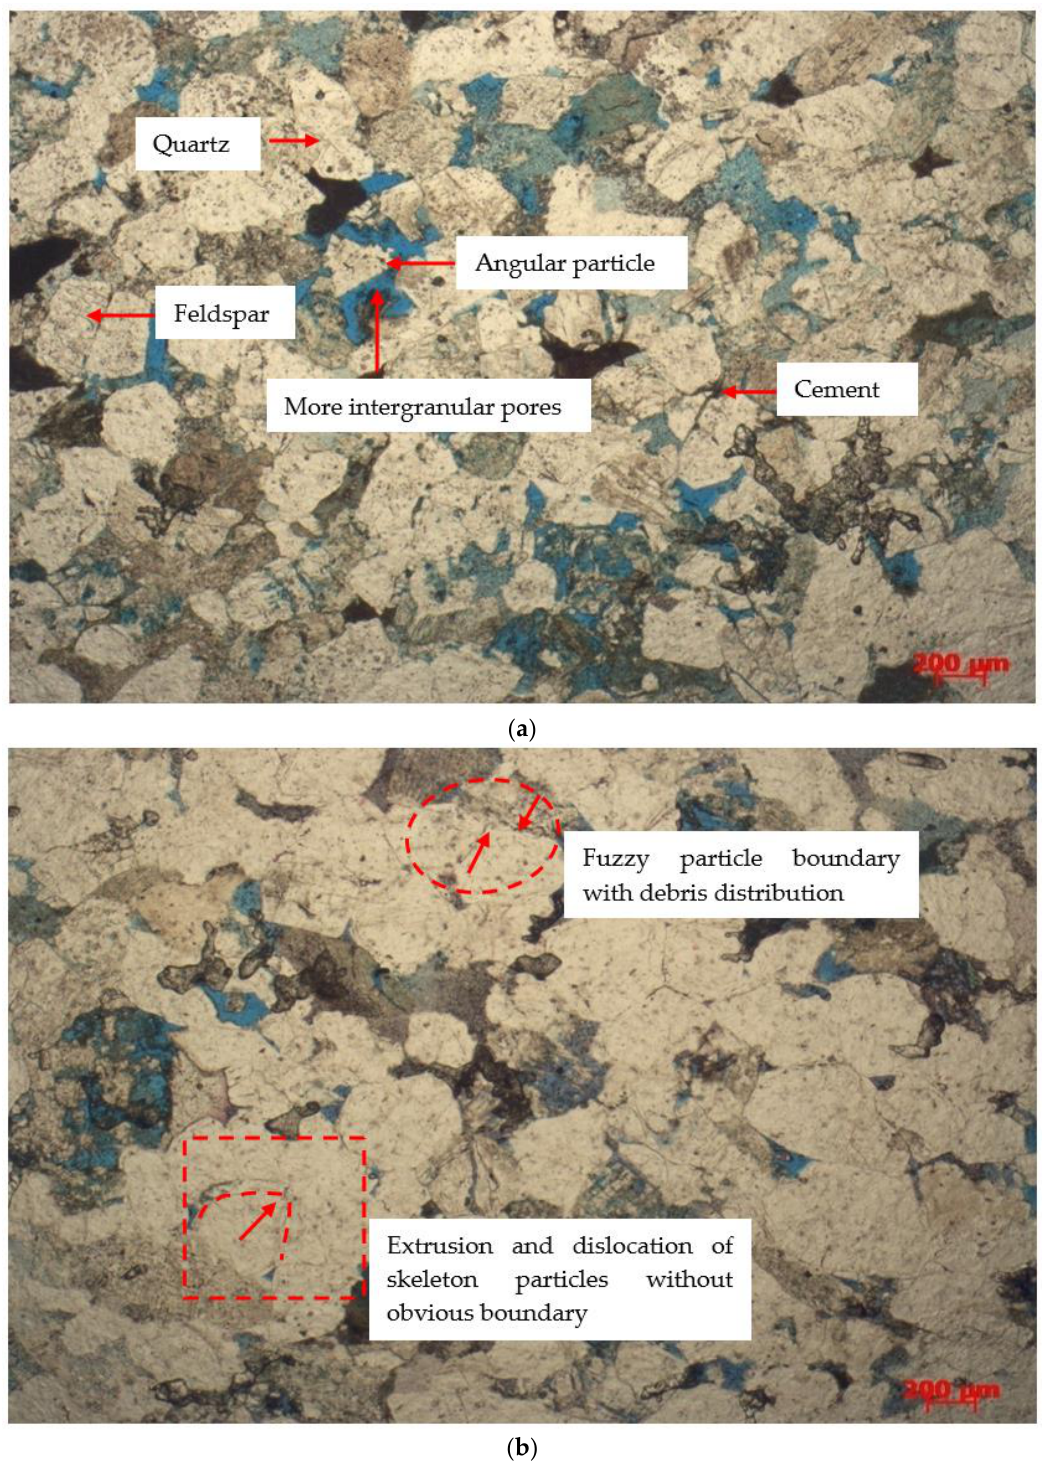
Figure 15. The destruction of pore structure caused by confining pressure: ( a ) sandstone structure before experiment; ( b ) sandstone structure after experiment, plane polarized light.